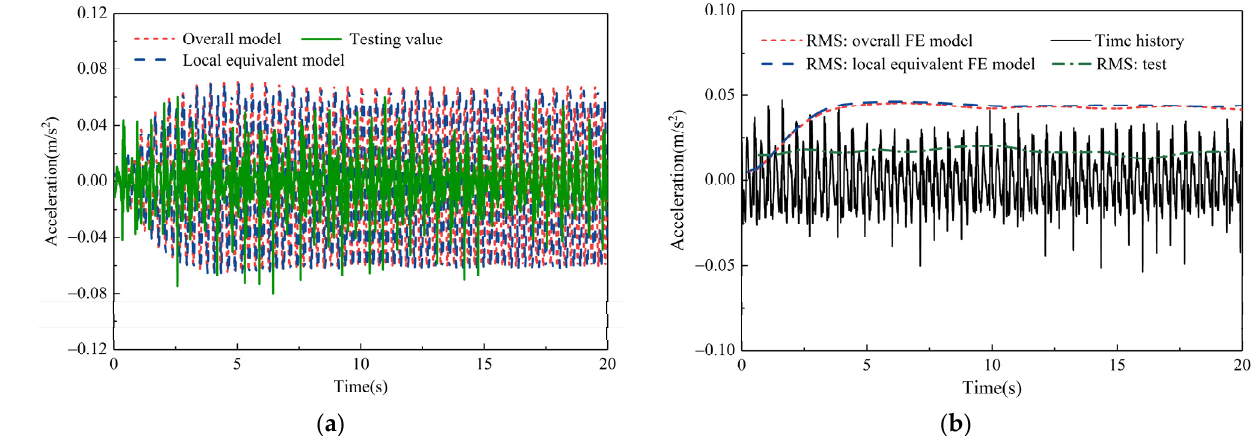
Figure 13. Comparison of numerical and measured acceleration time-history responses and 20 s RMS acceleration of the suspended floor under case WP-4: ( a ) acceleration time-history responses; ( b ) RMS acceleration.